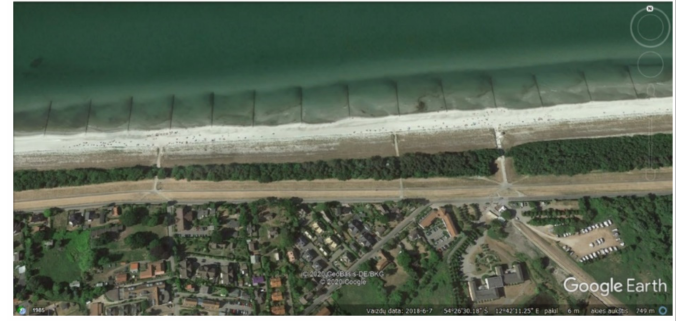
Figure 2. A Google Earth TM image of Zingst (Germany) taken on 7 June